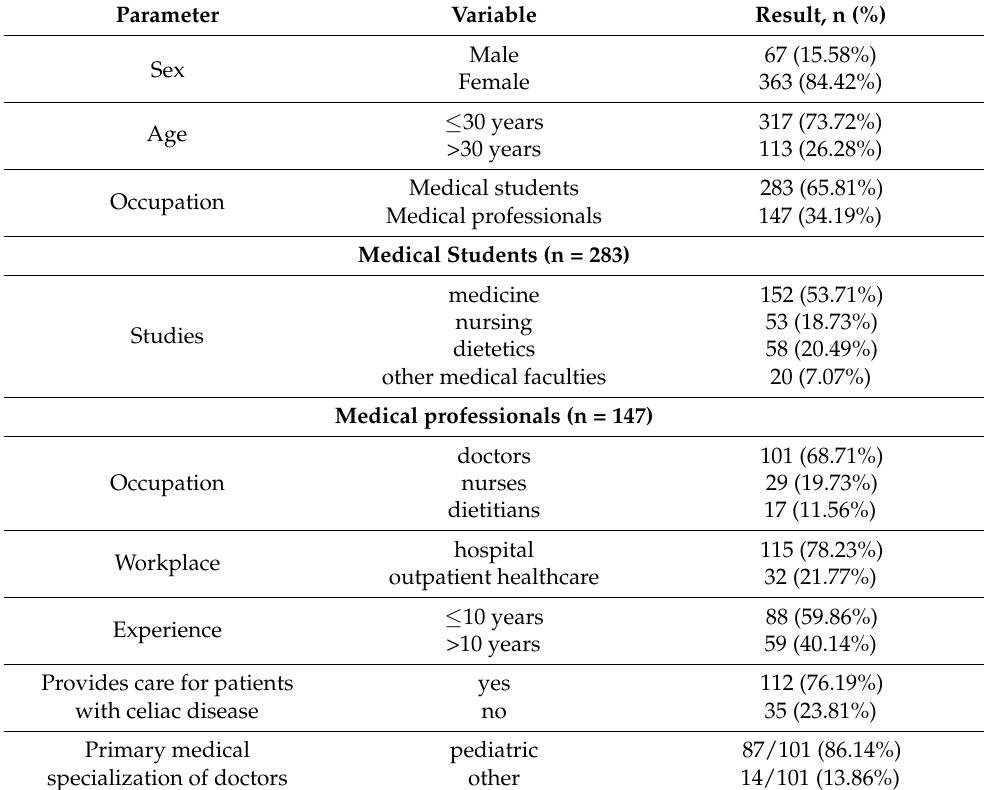
Table 1. Basic characteristics of the study participants.